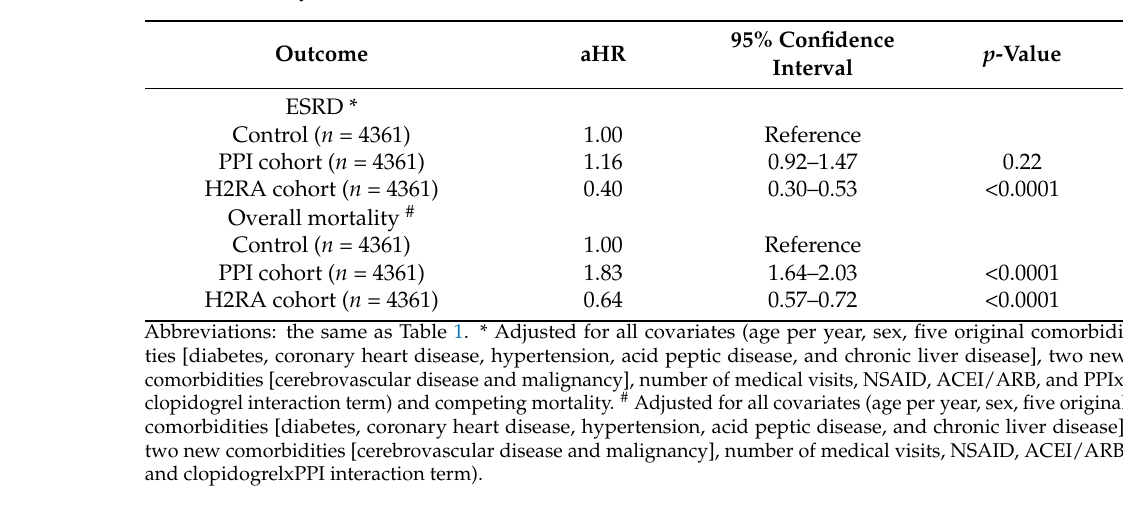
Table 2. Sensitivity analysis: Adjusted hazard ratio (aHR) for end-stage renal disease (ESRD) and overall mortality in three cohorts.